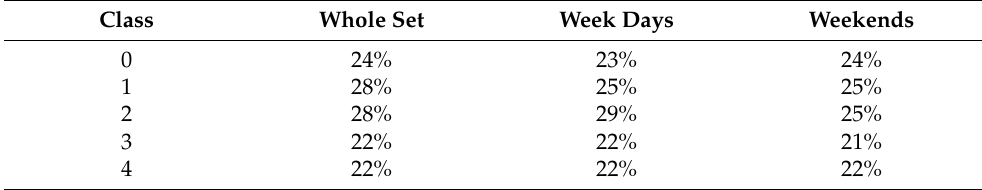
Table 4. Detailed results. Logistic coverage. Whole set, week days and